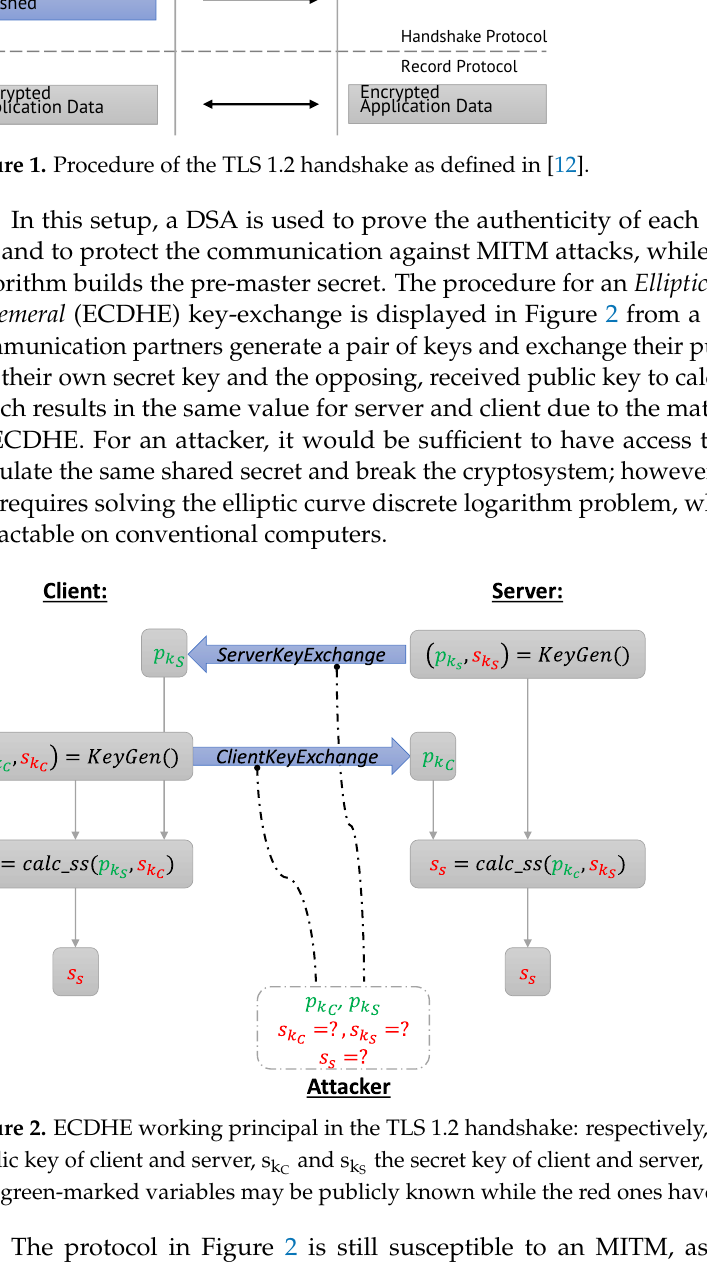
and s k the secret key of client and server, and s s the shared secret. C S